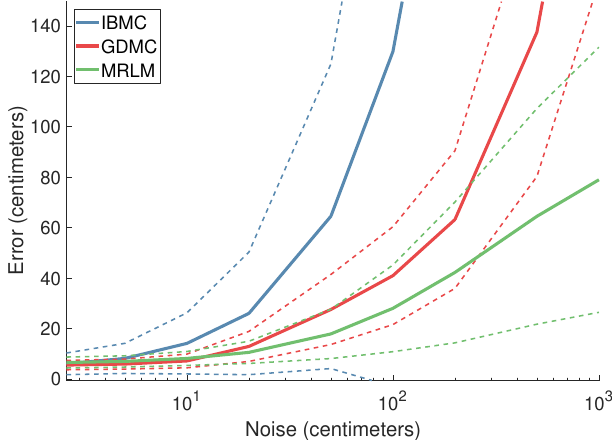
Figure 5. Error as a function of noise. We leave the pose database (and matrix) intact, but contaminate the to-be-completed pose vector with Gaussian noise, simulating uncertainty of real world sensors, and measure the resulting error. The x -axis shows noise standard deviation in centimeters on a logarithmic scale. Extreme noise values have been considered to showcase the performance of the algorithms in the broadest possible spectrum of noise contaminations. The dashed plots represent the standard deviation of the respective techniques.